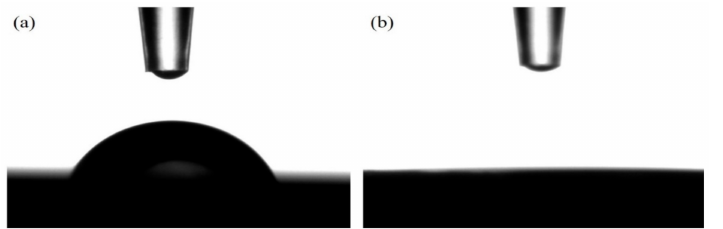
Figure 5. Surface contact angles of water droplets on the SiC NW film ( a ) before and ( b ) after Co 3 O 4 decoration.